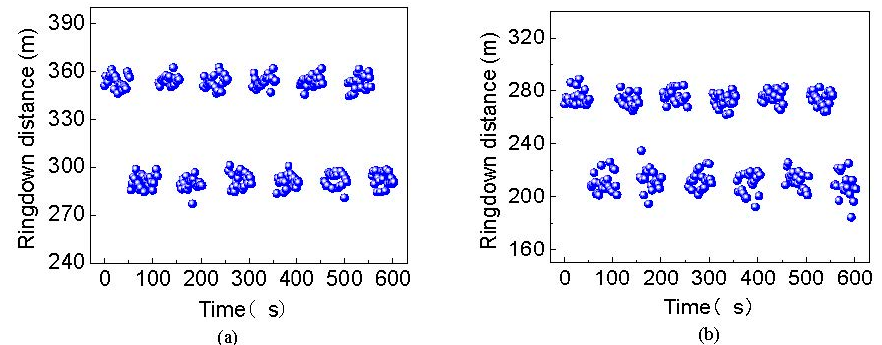
Figure 6. The repeated measurement results with relative strain of 2 m ɛ unloaded and loaded for ( a ) the sensing point 1 and ( b ) the sensing point 2.